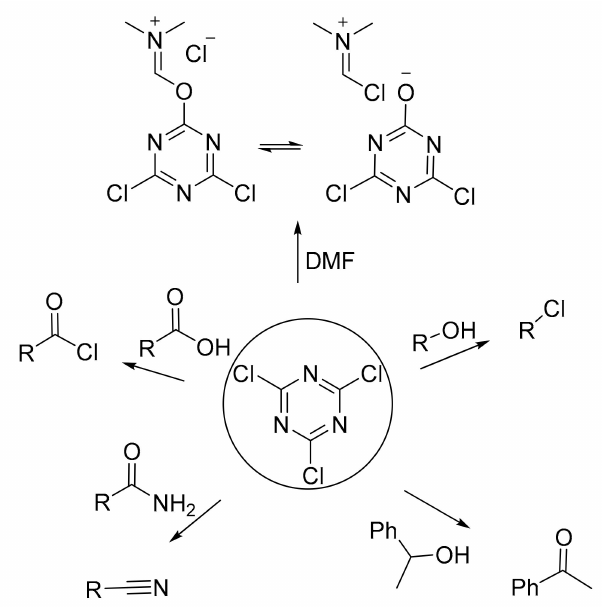
Scheme 1. General schematic example for using cyanuric chloride as a chemical